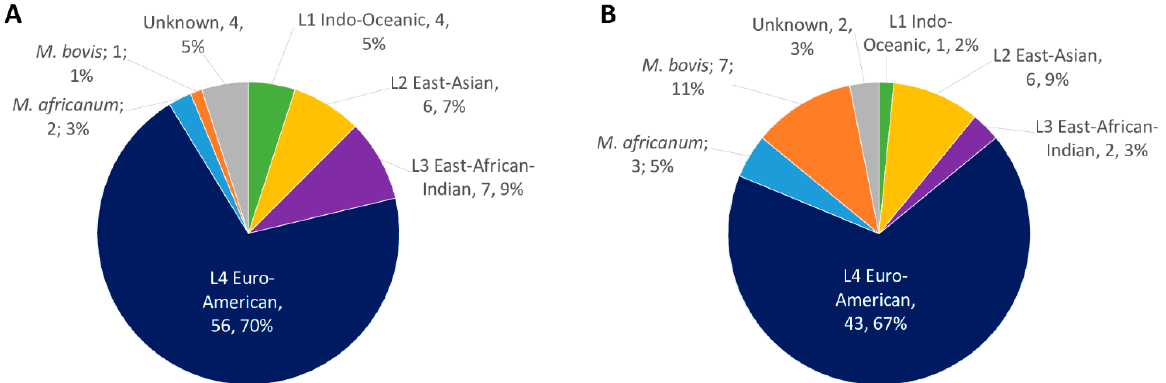
Figure 1. Epidemiology of 144 MTBC strains included in the study, separated on ( A ) training set ( n = 80 strains) and ( B ) validation set ( n = 64 strains). For both, the identification was based on membrane-based spoligotyping identification.